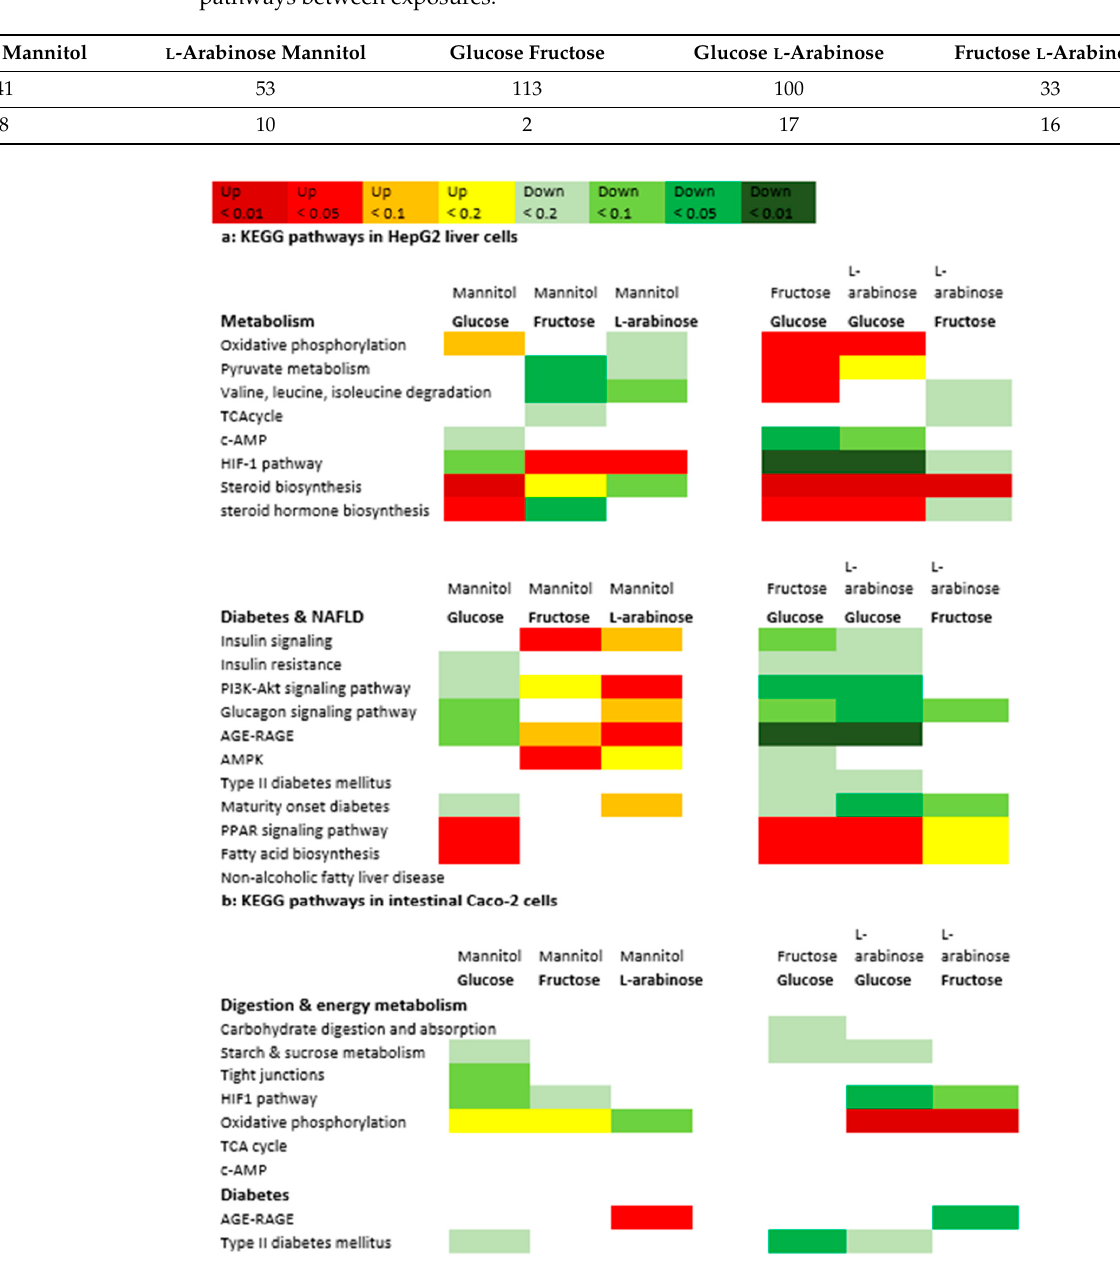
Table 2. Number of genes and KEGG pathways that are altered by the different sugars. Differential pathways between exposures.